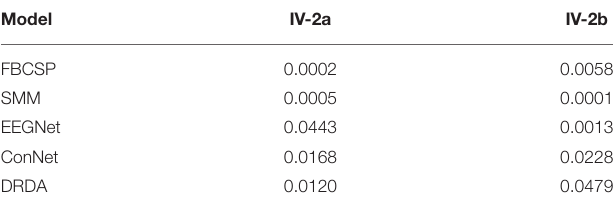
TABLE 5 | Paired t- test ( p -values) between our method and